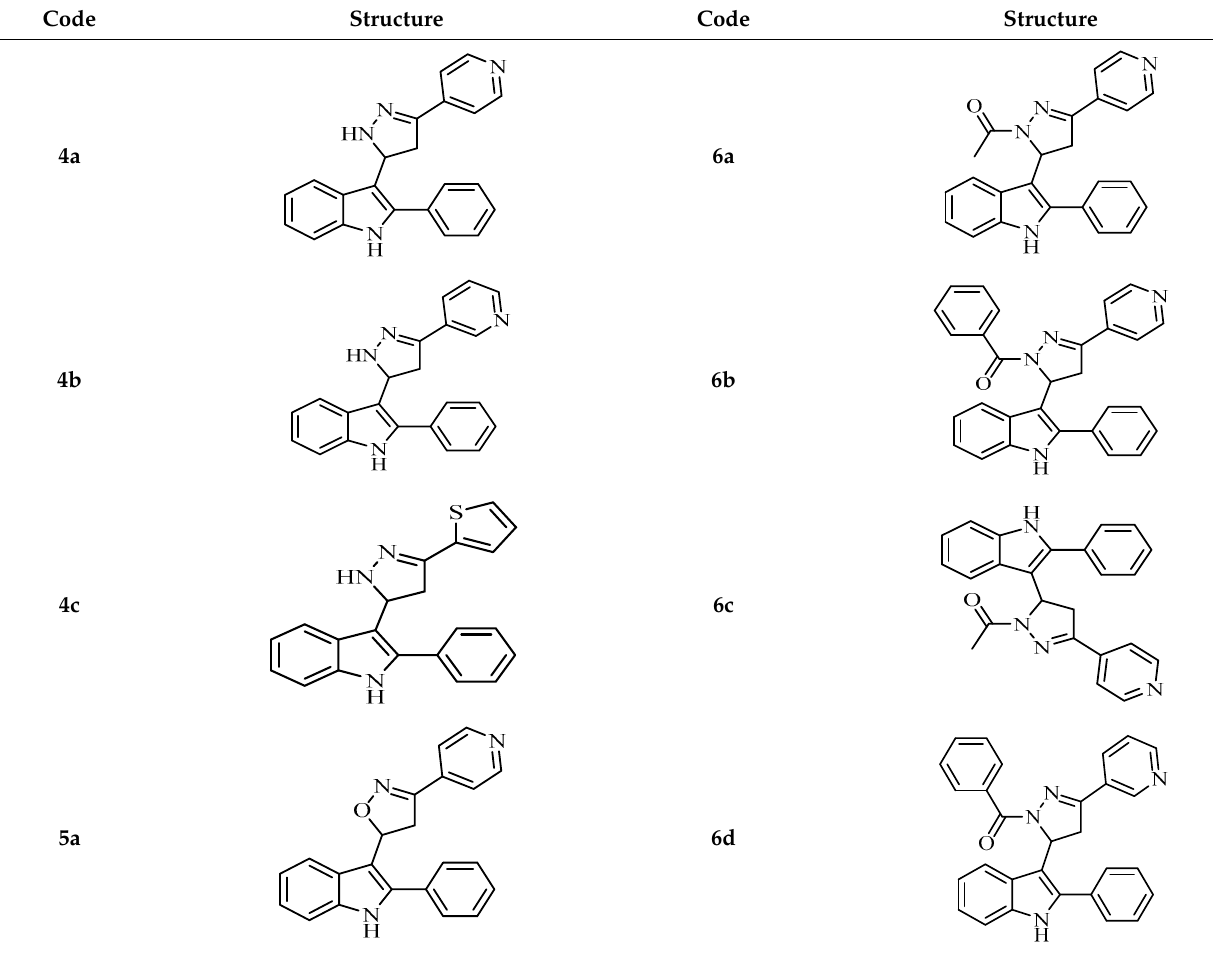
Table 4. Structures of reference compounds. Table 4. structures of reference compounds. Table 4. structures of reference compounds. Table 4. structures of reference compounds. Table 4. structures of reference compounds. Table 4. structures of reference compounds. Table 4. structures of reference compounds. Table 4. structures of reference compounds. Table 4. structures of reference